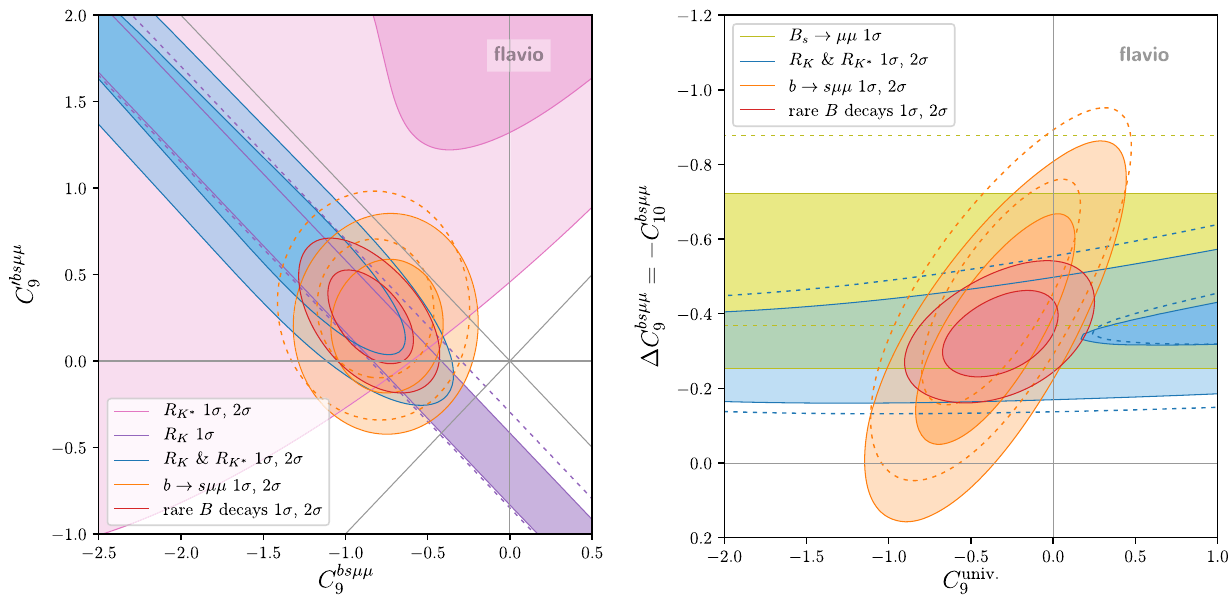
μμ (cid:6) bs μμ μμ = − C bs μμ vs. C (left) and C univ. vs. (cid:2) C bs (right). The dashed lines show the 9 9 9 9 10